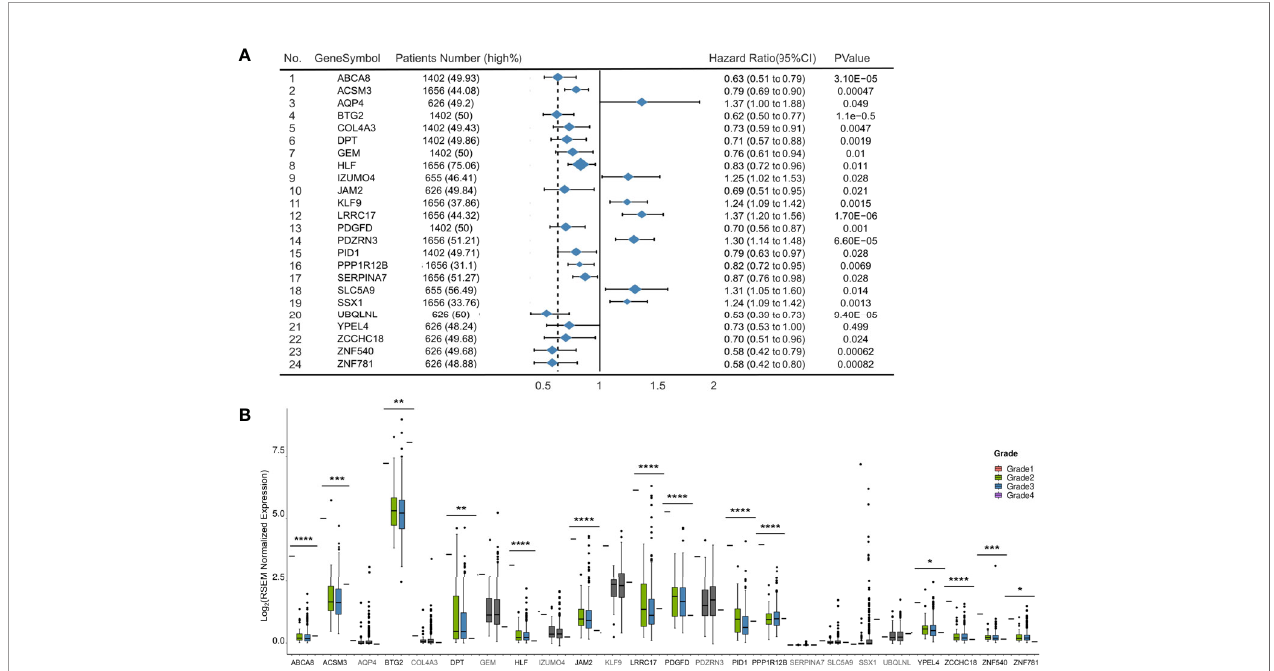
FIGURE 2 | Development of 94 tumor suppressors in survival and grade analysis. (A) Forest plot of 24 signi fi cantly expression genes. Hazard ratio and p-value are calculated by using a Kaplan-Meier analysis. (B) Boxplots (with median) showing the 14 out of 24 genes with expression levels in samples from TCGA signi fi cantly related to tumor grade. *p < 0.05, **p < 0.01, ***p < 0.001 and ****p <